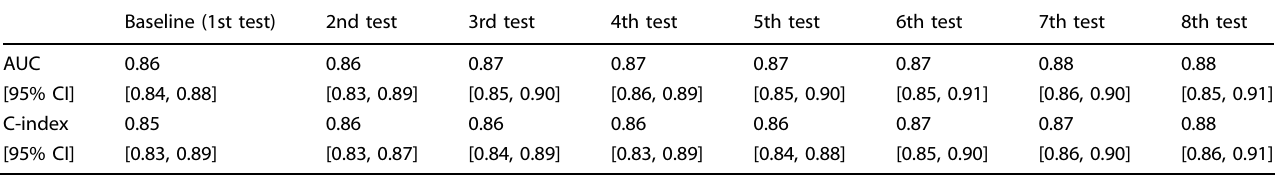
Table 4. Prediction strength of laboratory tests on successive days without using cut-off values.